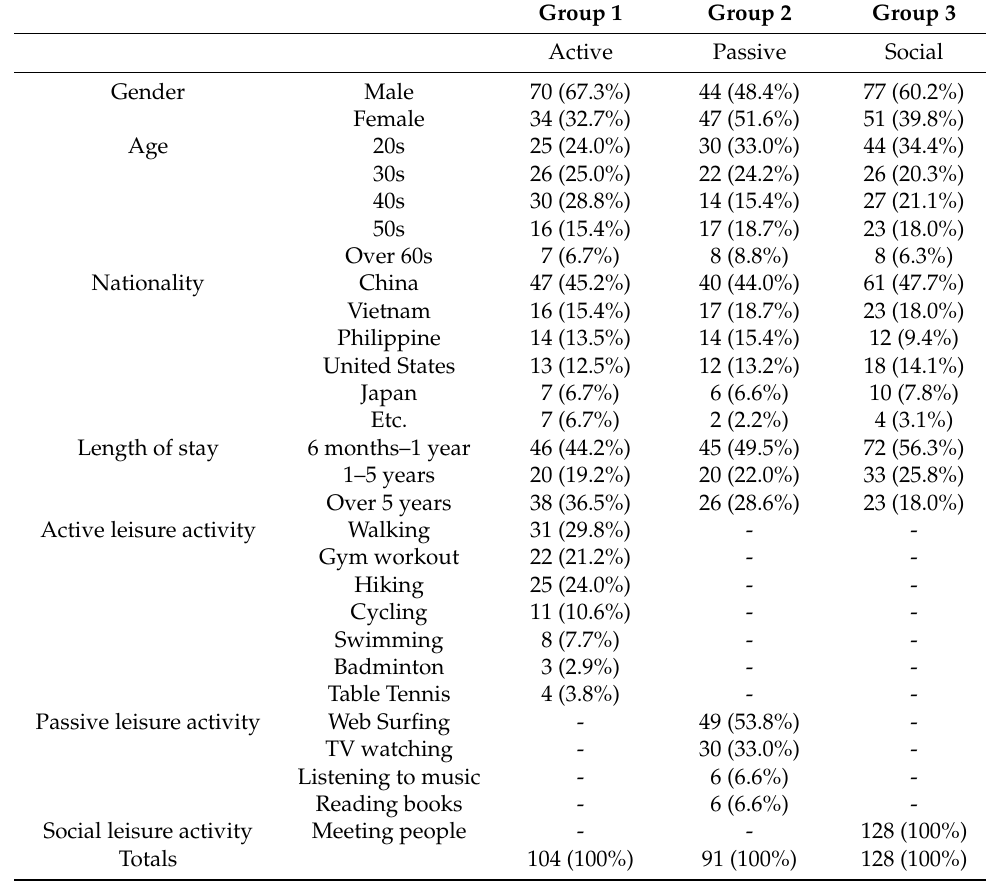
Table 1. Descriptive statistics by